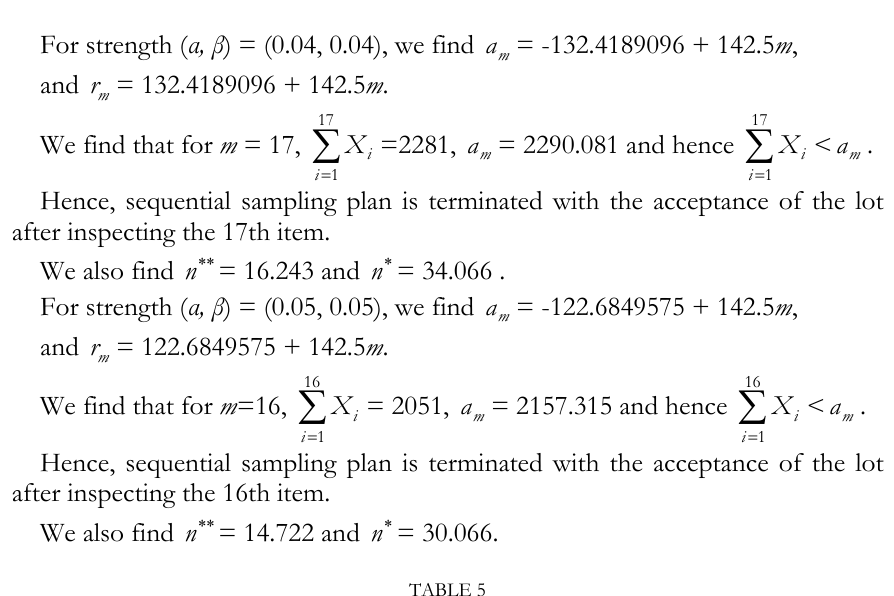
Sample size required for SPRT procedure and average percentage saving in size of sample with sequential procedure as comparedwith current most powerful test for testing mean of a normal distributed variate k 0.02 0.10 Sample size required for S.P.R.T